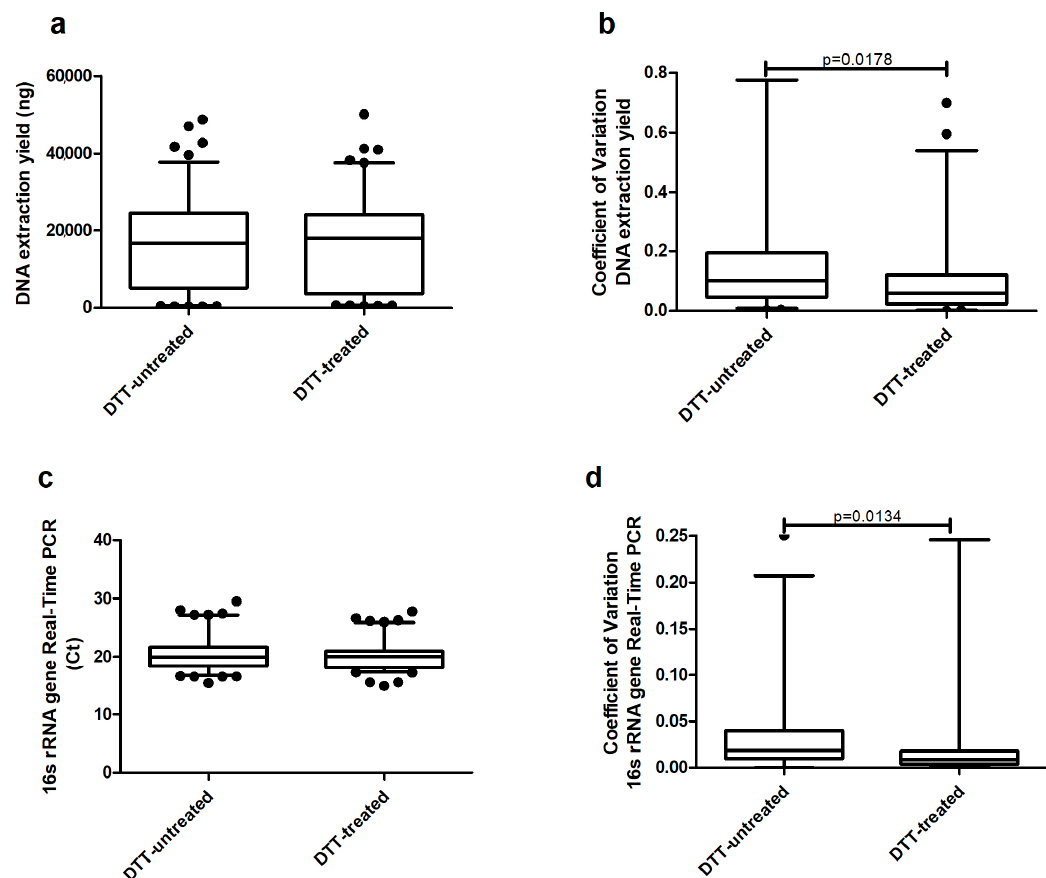
Figure 1. Comparison of median levels of ( a ) DNA extraction yield, ( b ) coefficient of variation between replicates, ( c ) 16s rRNA gene real-time PCR results, and ( d ) coefficient of variation between replicates across dithiothreitol (DTT)-untreated sputum vs. DTT-treated (Experiment 1).